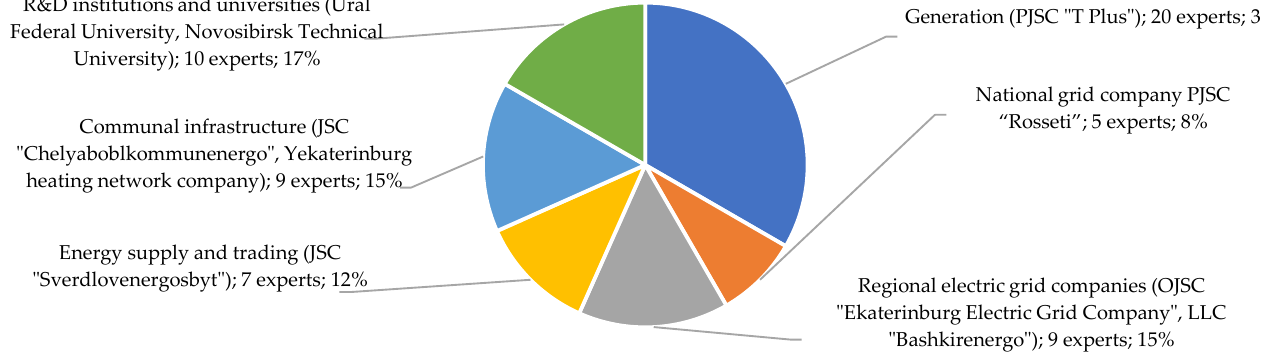
Figure 2. Russian respondents’ breakdown by energy sectors.